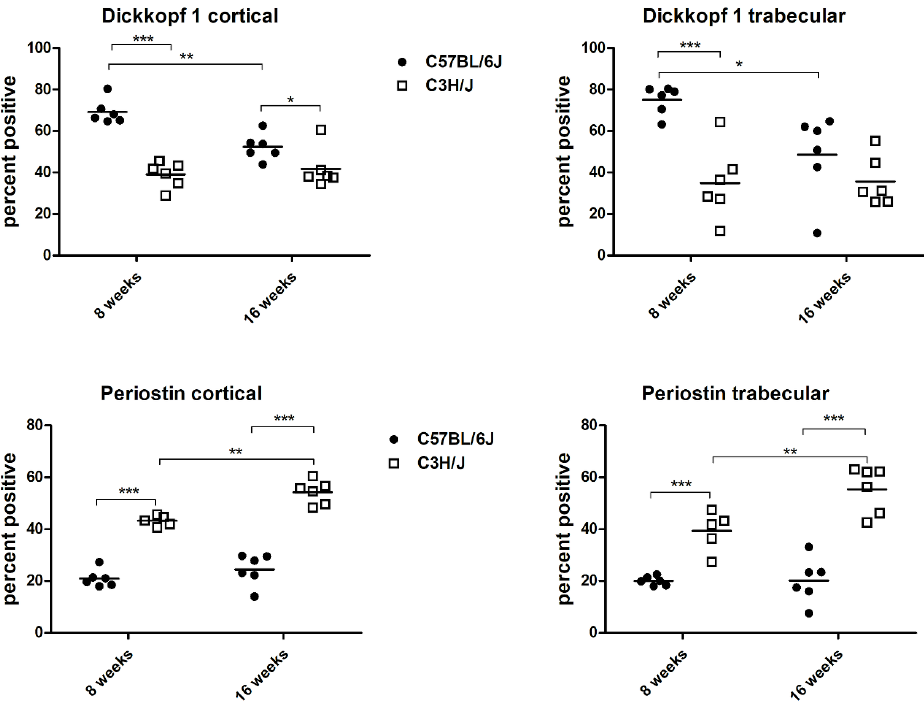
Figure 2. Cortical and trabecular osteocytes positive for dickkopf 1 and periostin; * p < 0.05, ** p < 0.01, *** p < 0.001. Although histomorphometry did not reveal significant differences between the two mouse strains, at eight weeks of age, BV/TV and Tb.Th tended to be higher in the C3H/J mice. (Figure 3).